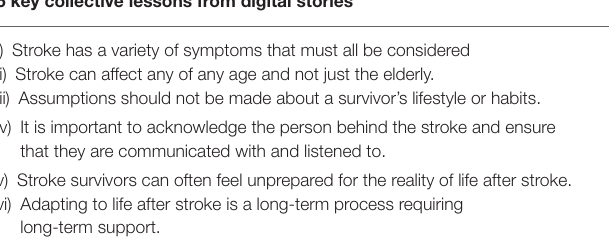
TABLE 7 | Final six collective lessons chosen by participants to be addressed by digital